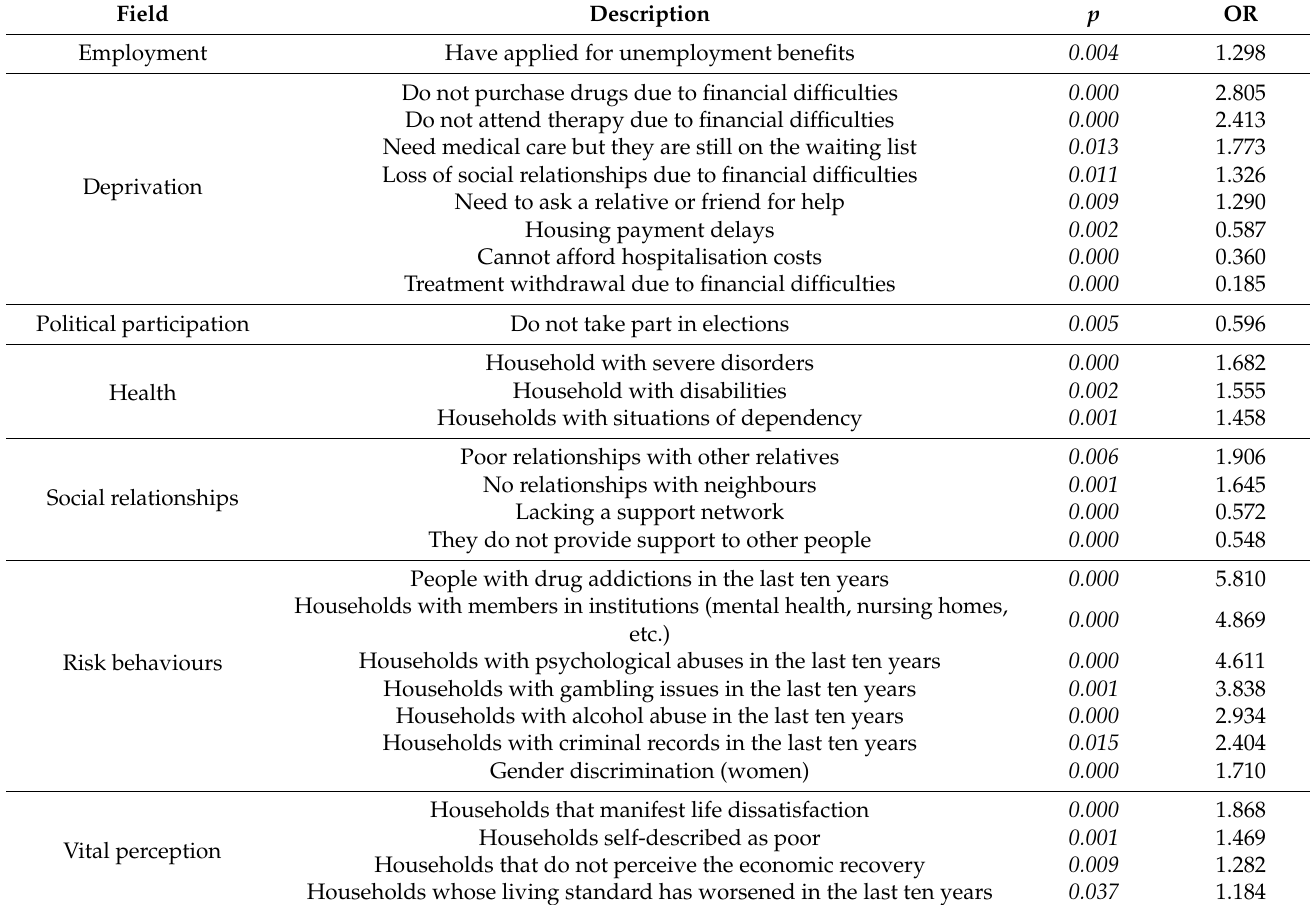
Table 2. Variables included in the risk model, significance level ( p ) and corresponding Odds Ratio